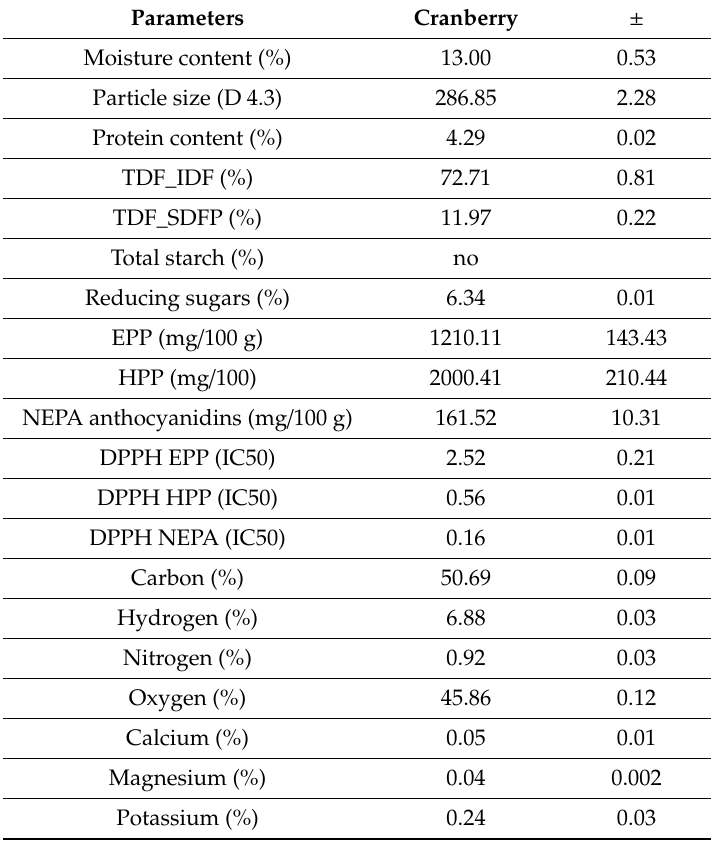
Table 1. Physical and chemical properties of cranberry pomace supplied by Fruit d’Or Inc.